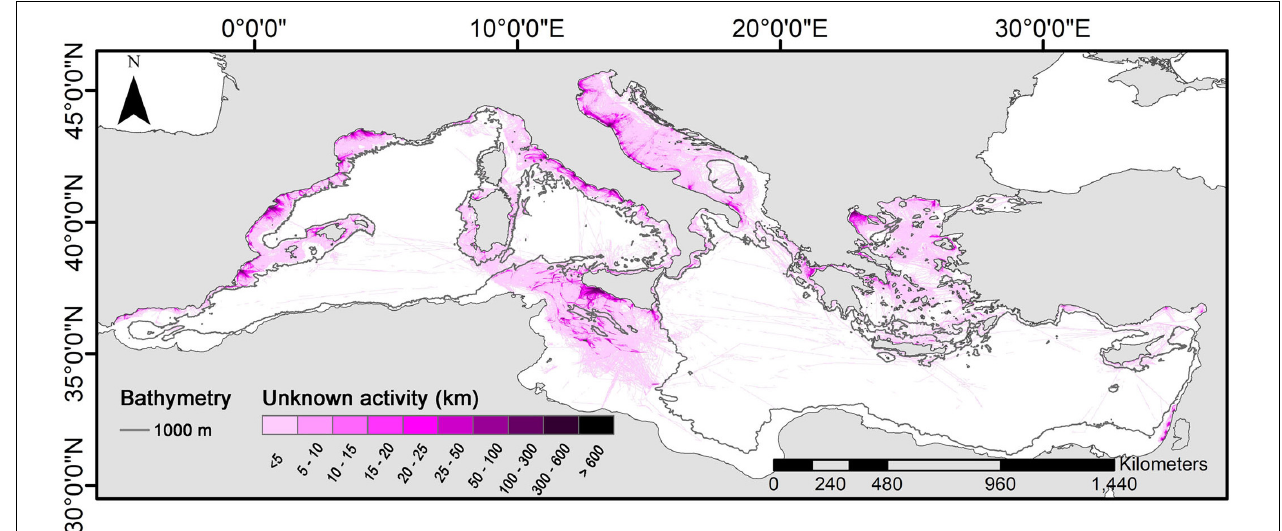
FIGURE 2 | AIS-based unknown activity map (km) aggregating the unknown tracks.